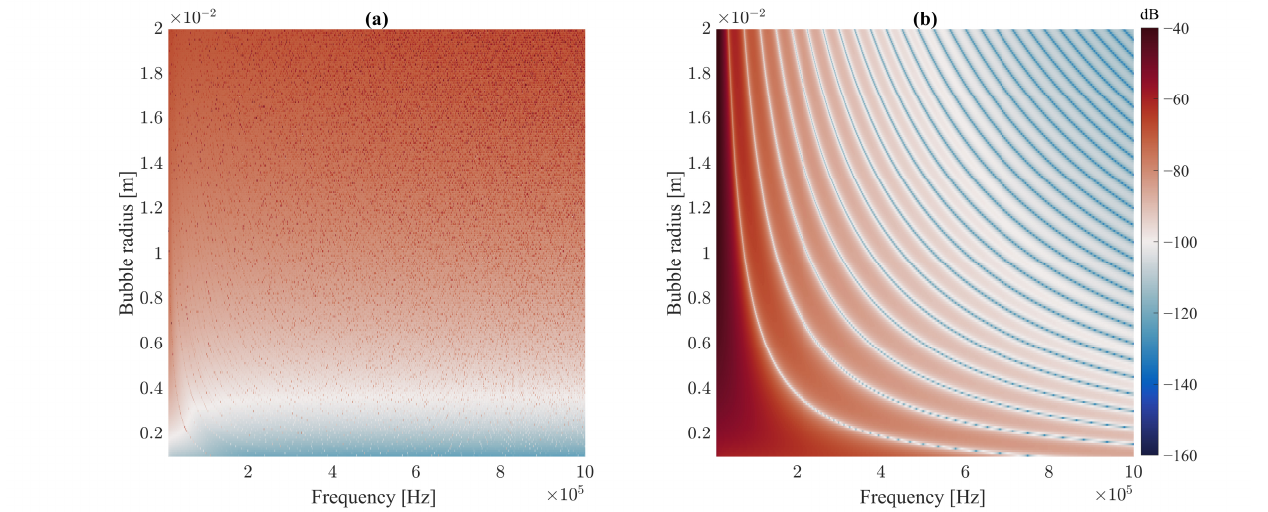
Figure 3. Two solutions used to calculate the target strength of a single gas bubble: ( a ) modal solution and ( b ) Thuraisingham solution.